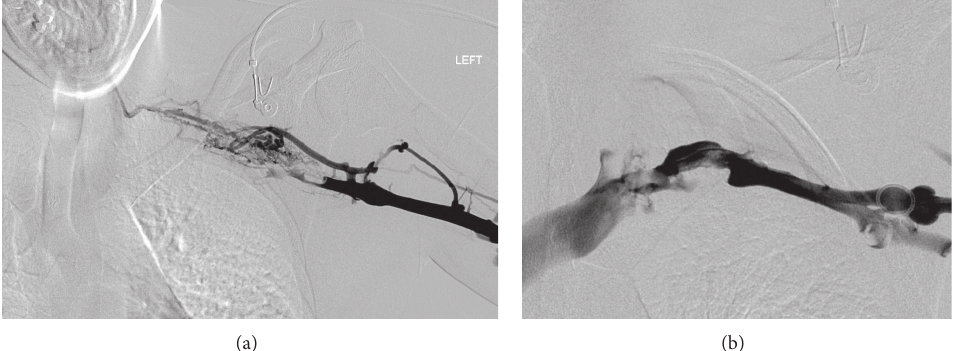
Figure 2: (a) Digital subtraction venogram showing occlusive thrombus in the axillary and subclavian veins with extensive collateralisation. (b) Digital subtraction venogram following PMT. Flow through the axillary and subclavian veins has been restored with minimal residual thrombus. A stenosis is seen in the first rib.